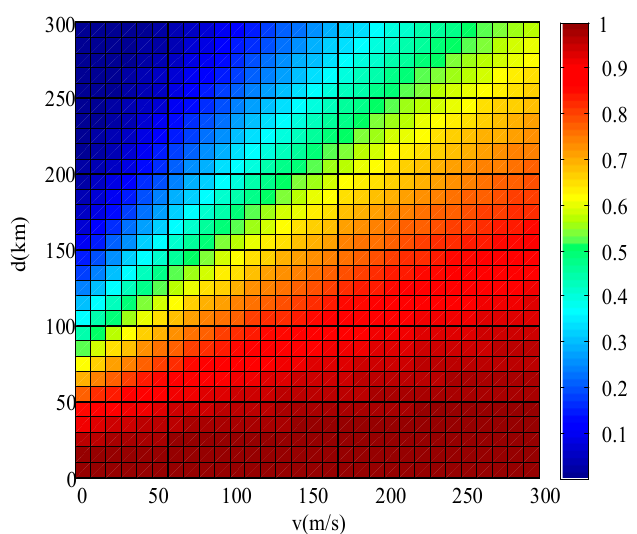
Figure 4. The target threat priorities with different distances and velocities.